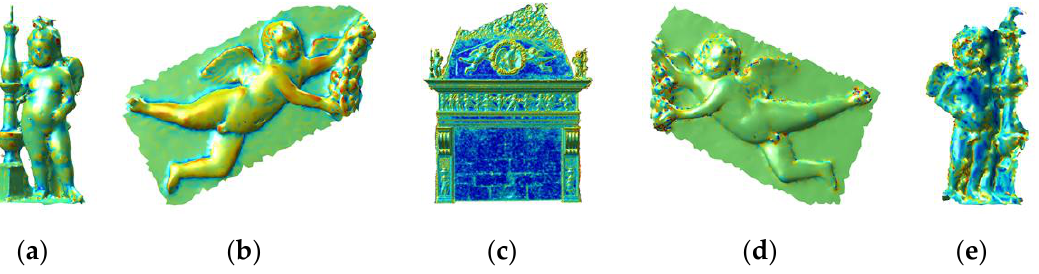
Table 1. Ordered statistic criteria ranking (Section 3.4 [27]).